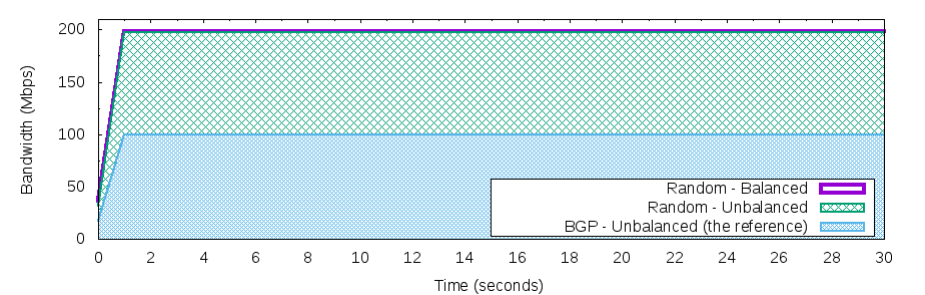
Figure 7. Random load balancer results.